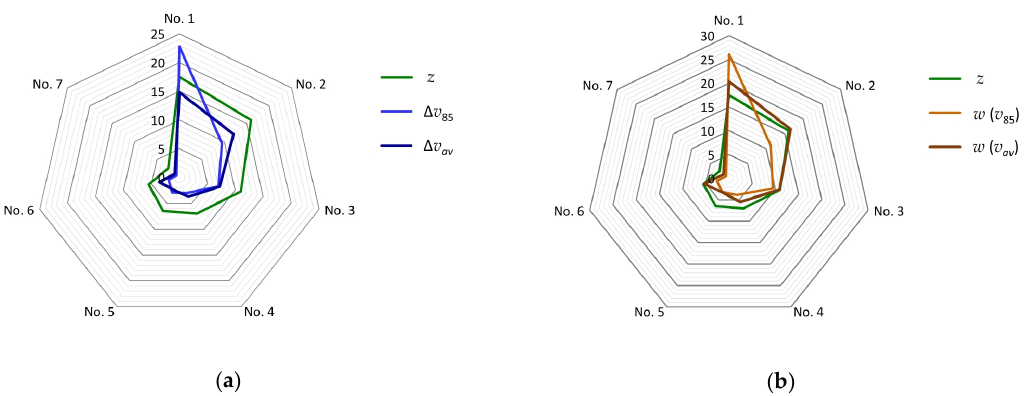
Figure 18. Compilation of changes in the analysed variables: ( a ) consistency of the speed reduction variations ∆ v 85 and ∆ v av and aggregate parameter z ( R = 0.76 and R = 0.93 respectively); ( b ) consistency of variation of the speed reduction index w ( v 85 ) and w ( v av ) and aggregate parameter z ( R = 0.80 and R = 0.94, respectively).